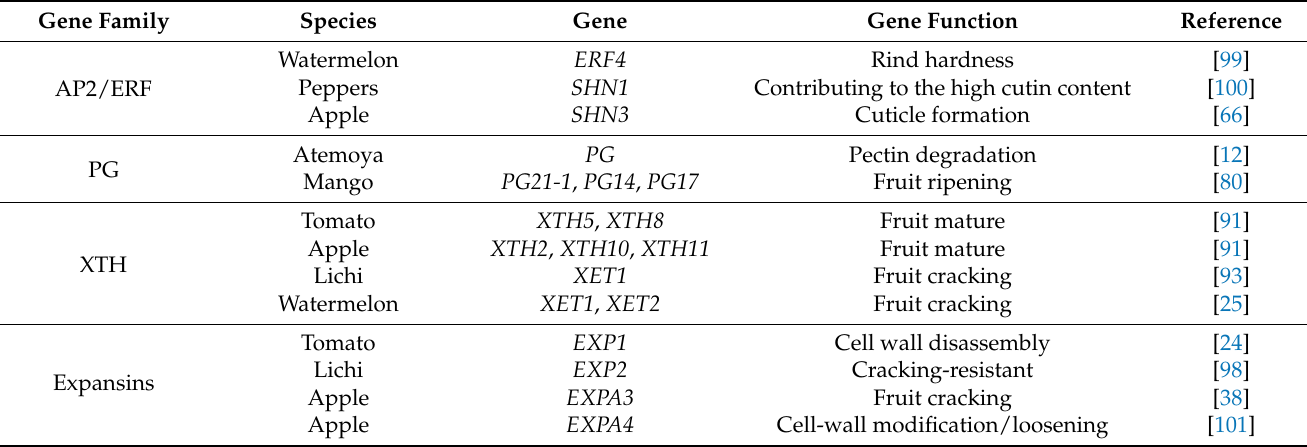
Figure 2. A schematic diagram of the fruit cracking associated with the cuticle membrane and cell wall. Related genes ( LCS2 , GPAT4 , SHN1 , SHN3 ) in the cuticular membrane regulate cutin biosynthesis. The gene families involved in cell wall metabolism are the polygalacturonase (PG) gene family, xylan endoglucosidase/hydrolase (XTH) gene family, and expansin gene family. Some genes ( PG14 , XTH1 , EXP1 , EXPA3 ) of these families are involved in the degradation of pectin, which results in fruit cracking. Table 2. Identified genes related to fruit